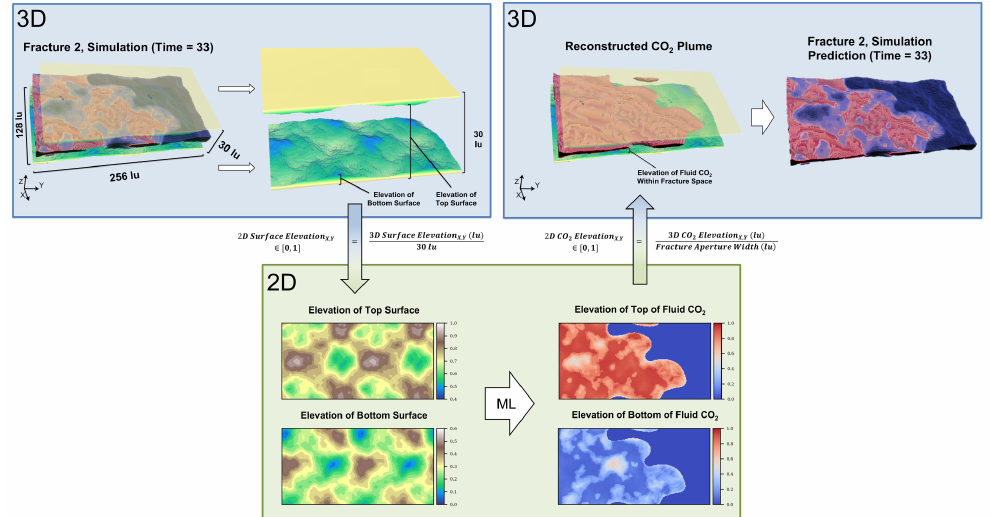
Figure 2. Workflow for projecting 3D simulations into two dimensions for one time step (33) in the simulation for Fracture 2 in our dataset. The equations show the conversions between the 3D data and its corresponding 2D